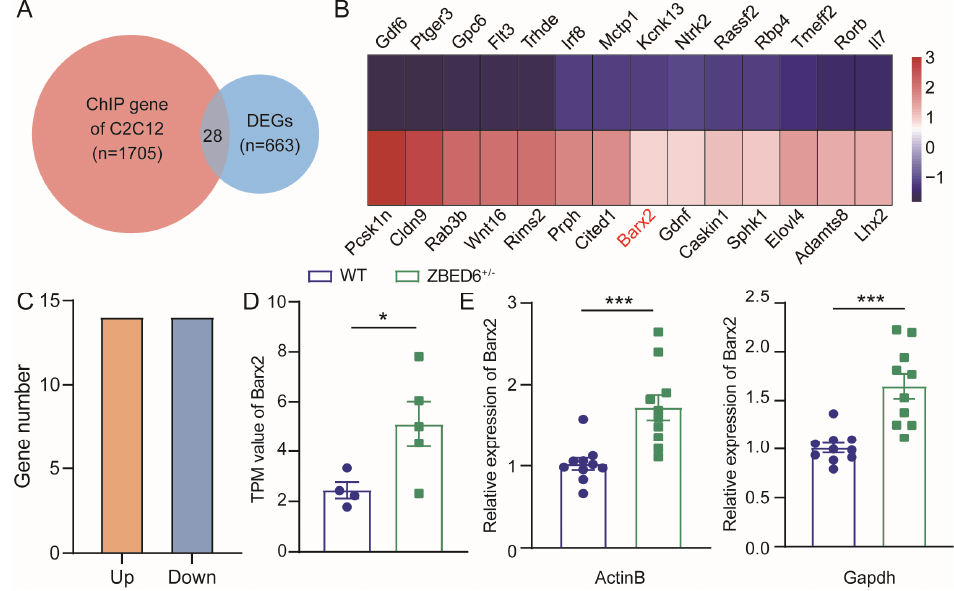
Figure 7. The identification of candidate genes. ( A ) Overlapped DEGs and ChIP genes. Red circle indicates ZBED6 target genes derived from ChIP-seq of murine C2C12 cells. Blue circle indicates DEGs. ( B ) Heatmap of common 28 genes. The genes marked in red and blue were upregulated and downregulated, respectively. ( C ) Number of upregulated and downregulated genes. ( D ) TPM value of Barx2 , n = 4:5. ( E ) The mRNA expression level of Barx2 , n = 10:10. The results were expressed by the means ± SEMs. * p < 0.05, and *** p < 0.001; Student’s t-test. Points in different colors represent actual data of mice.